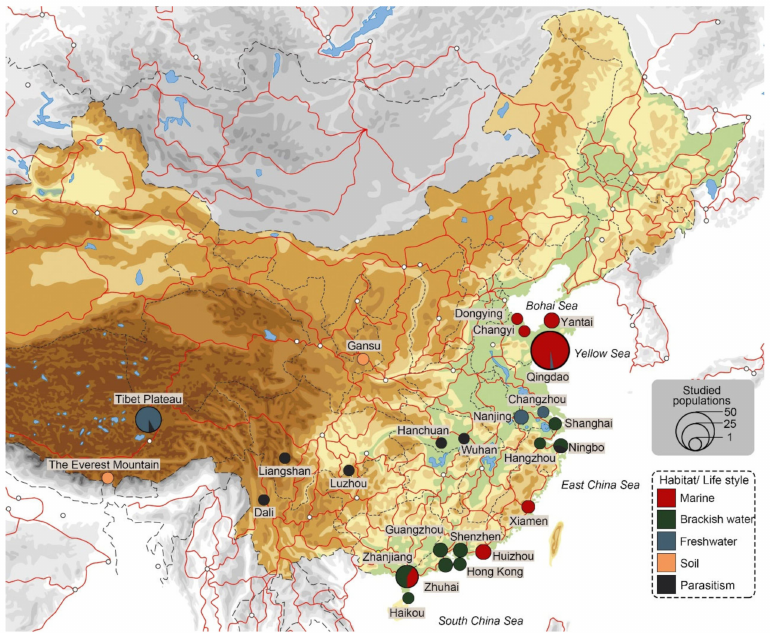
Figure 7. Sampling sites and habitat categories (or lifestyles) of studied cyrtophorian ciliate popula- tions from China. The dots represent study sites, and the sizes of the dots indicate the number of populations studied. Colors represent different habitat types or